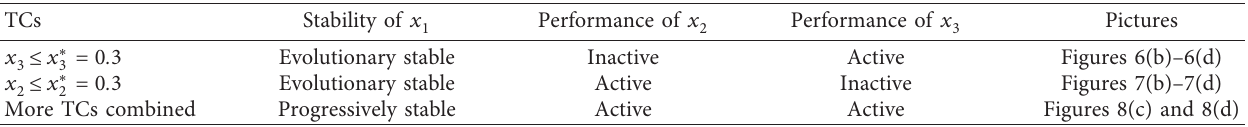
Table 1: Evolutionary stabilities of the dynamical system with different